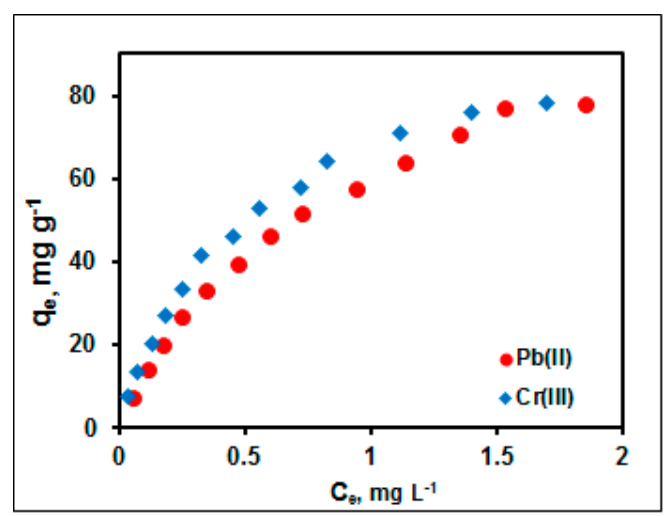
Figure 8. Adsorption isotherms of Pb(II) and Cr(III) ( C o = 2.0 to 25.0 mg·L − 1 ) onto rGONF at pH 5.0 for Pb(II) and pH 4.0 for Cr(III), at 30 min equilibrium time for the range of reaction temperatures, 298–328 ± 2.0 K.